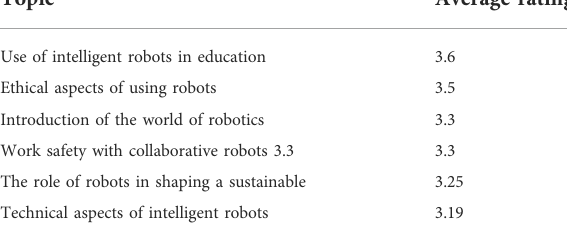
TABLE 3 Learners ’ evaluation of the required course